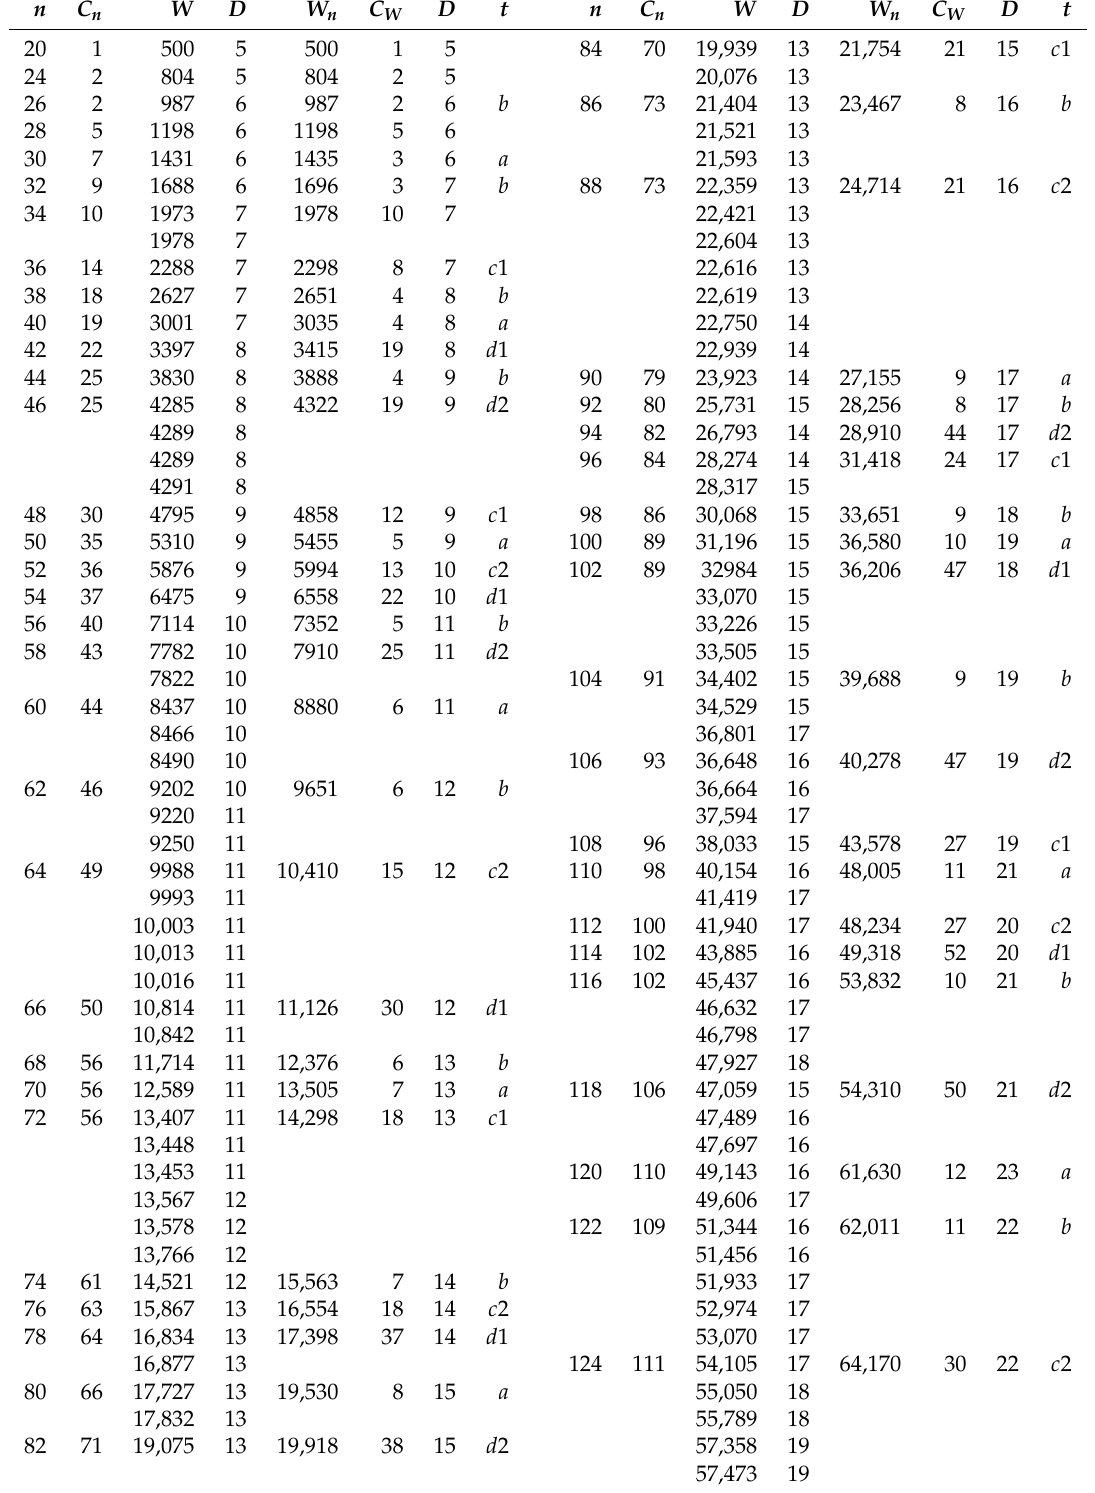
Table 1. Maximal Wiener complexity and Wiener indices of fullerene